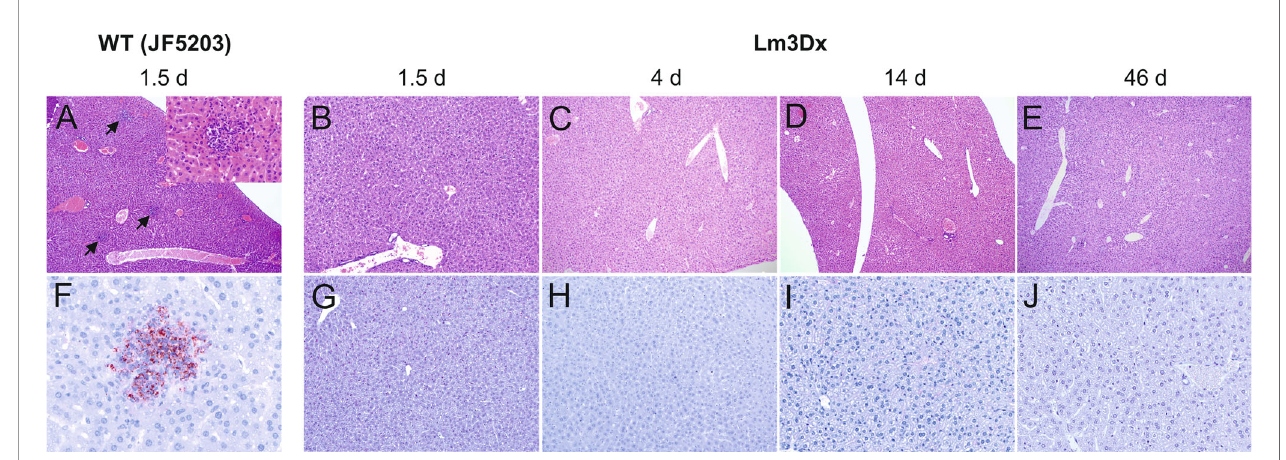
FIGURE 5 | Representative HE (A – E) and immunohistochemically (antibody against Lm) (F – J) stained liver tissue of WT- and Lm3Dx_SAG1- injected mice. (A) Multifocal necrosuppurative hepatitis (arrows) in mice at 36h following injection with WT Lm (40x magni fi cation). Inset: 400x magni fi cation of a small hepatic abscess with aggregations of neutrophils obliterating hepatic cords. (B – E) Livers of mice injected with 1 x 10 7 Lm3Dx_SAG1 are normal, without lesions of necrosuppurative hepatitis at all time points: (B) 1.5d (100x magni fi cation) and (C) 4d (40x magni fi cation) following inoculation, (D) 14d (40x magni fi cation) and (E) 46d (40x magni fi cation) following the second boost injection. (F) Necrosuppurative foci contain myriads of bacteria at 1.5d following inoculation with WT Lm (400x magni fi cation). (G – J) Livers of mice injected with 1 x 10 7 Lm3Dx_SAG1 do not contain any bacteria throughout the experiment: (B) 1.5d (100x magni fi cation) and (C) 4d (100x magni fi cation) following inoculation, (D) 14d (200x magni fi cation) and (E) 46d (200x magni fi cation) following the second boost